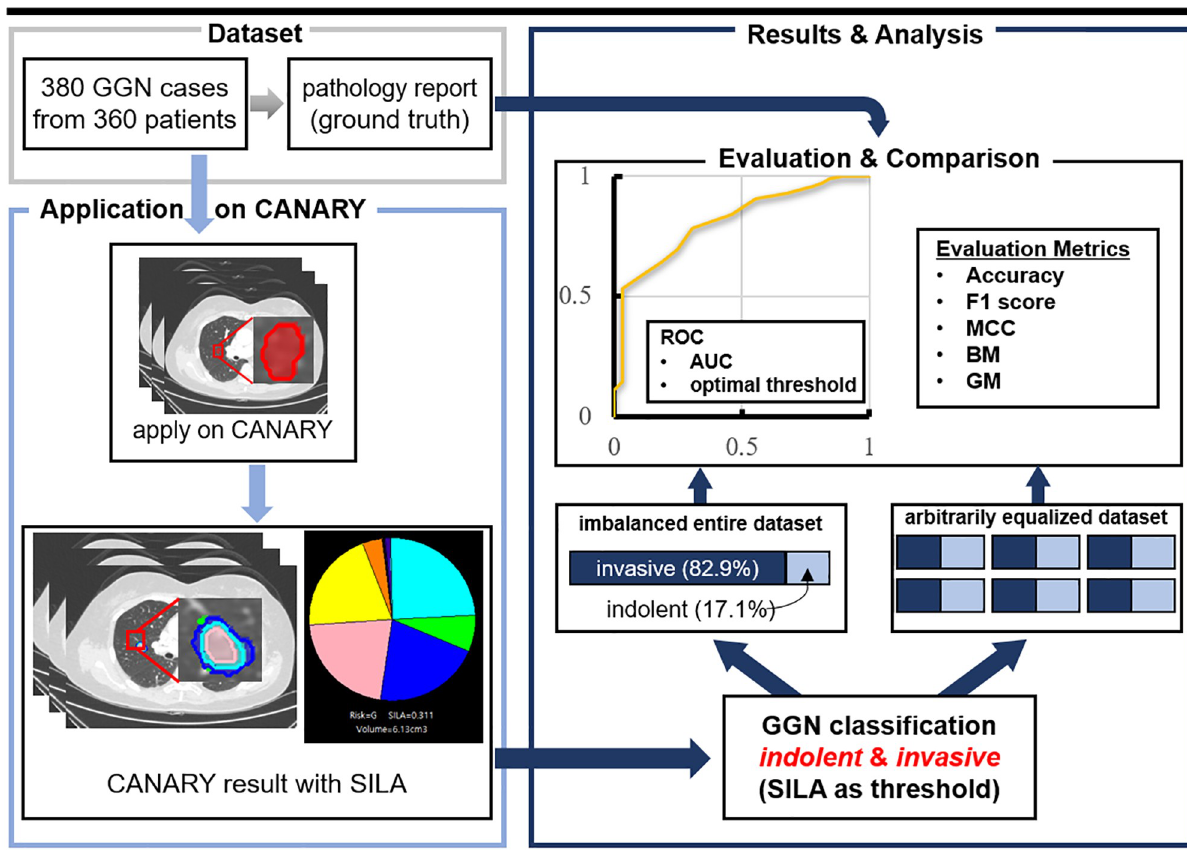
Fig 1. Flowchart of Computer-Aided Nodule Assessment and Risk Yield (CANARY) validation study. CT images from the 360 patients were applied on CANARY, and classification result analysis was performed on the entire dataset and the uniformly resampled dataset, respectively. Then, the quantitative scores were checked by using evaluation indicators and compared with the scores from the confirmed pathology